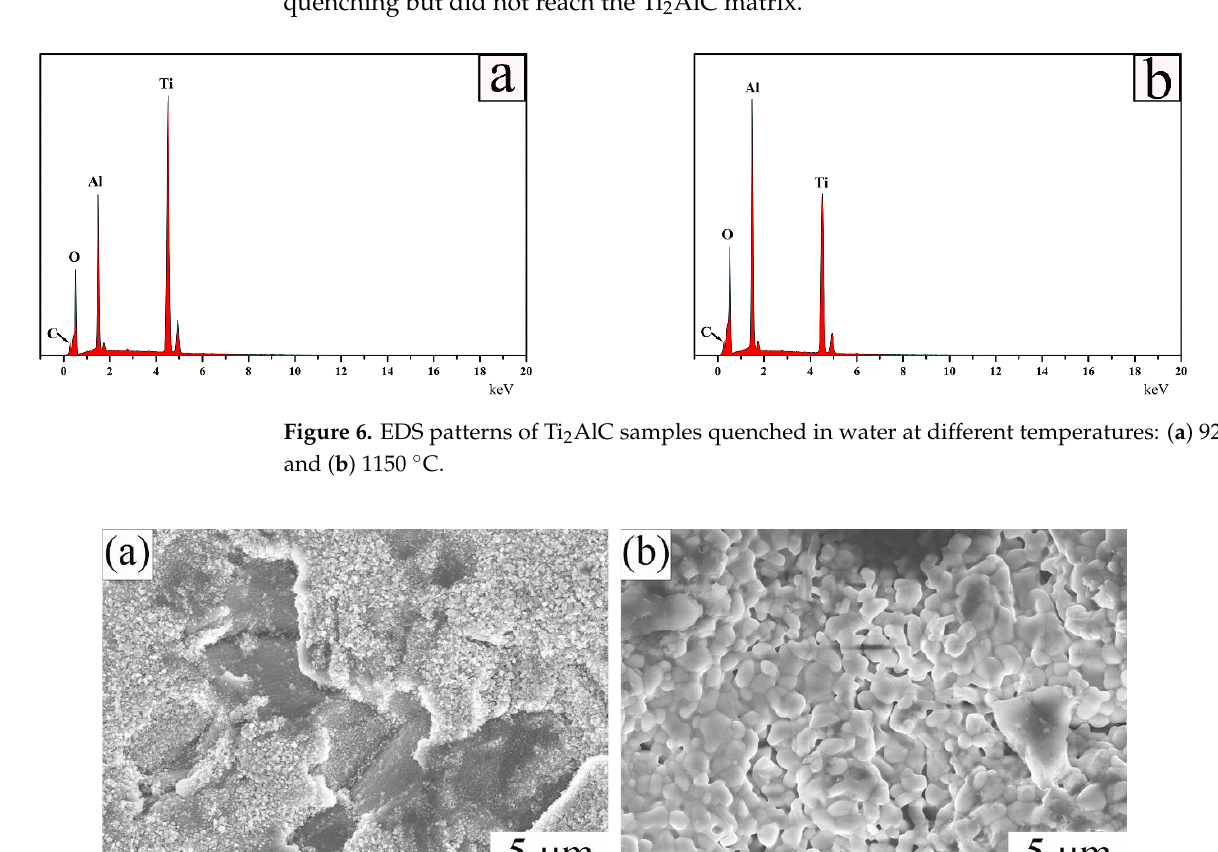
Figure 5. XRD patterns of Ti 2 AlC samples quenched in water at different temperatures: ( a ) 25 °C,